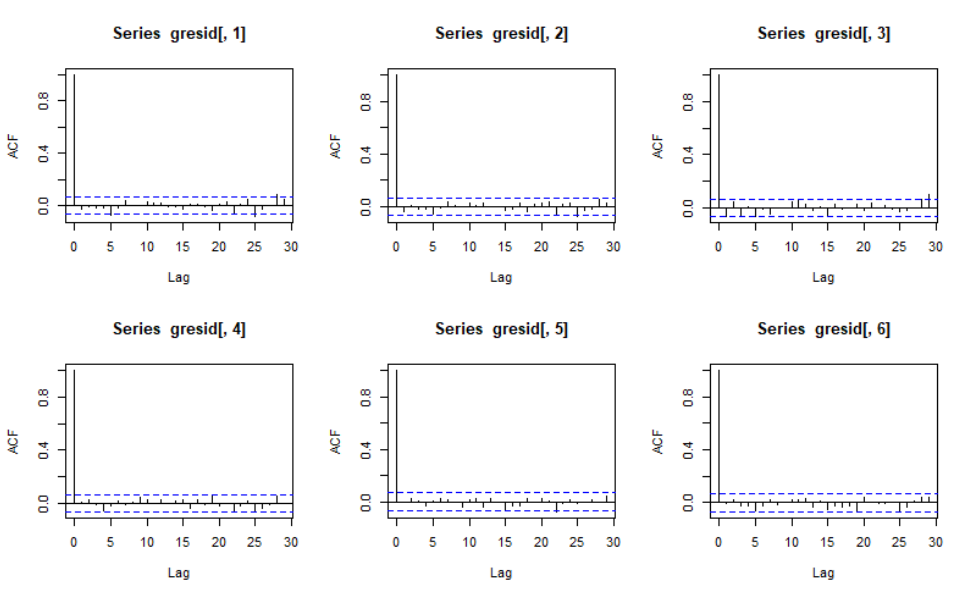
Figure 4. Plots of autocorrelation functions (ACF).